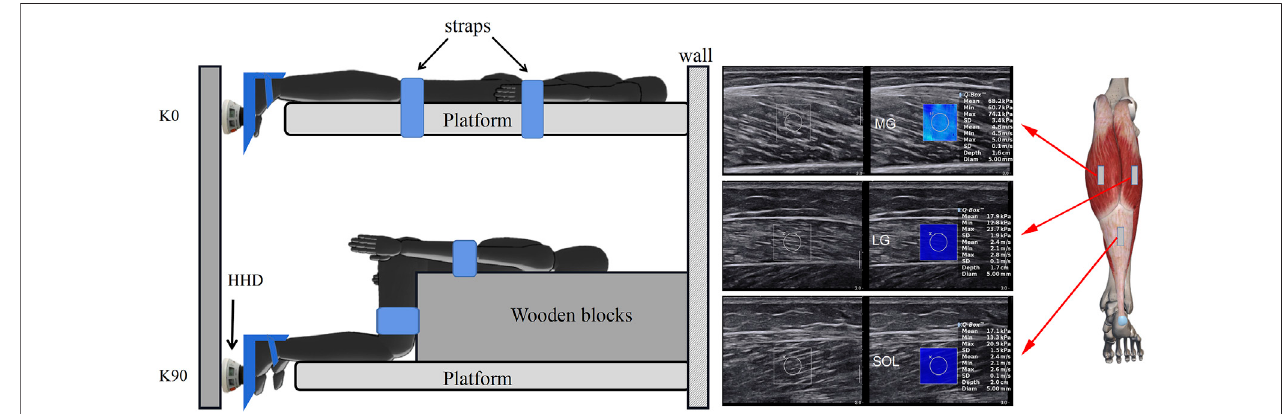
FIGURE1| Schematic diagramoftheshearmodulusoftriceps suraecomponentsduring isometricplantar fl exion.Intheextended knee(K0), asubjectwasprone andthetrunkwassecuredtotheplatformusingstraps.Inthe fl exedknee(K90),aheavywoodenblockwasplacedinfrontofthethightoavoiddisplacementofthelower leg during isometric contraction. The force of the ankle plantar fl exors was measured at 0 ° (neutral position) using a hand-held dynamometer (HHD) that was placed on the fi rst metatarsal. MG: medial gastrocnemius; LG: lateral gastrocnemius; and SOL: